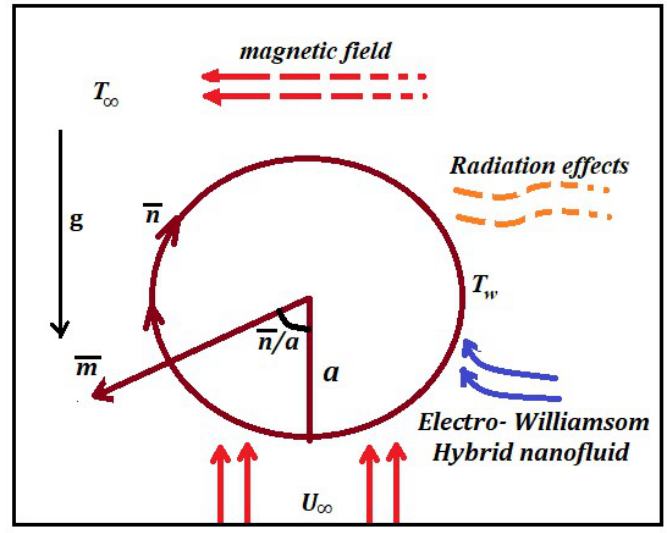
Figure 1. MHD Williamson hybrid nanofluid physical model.